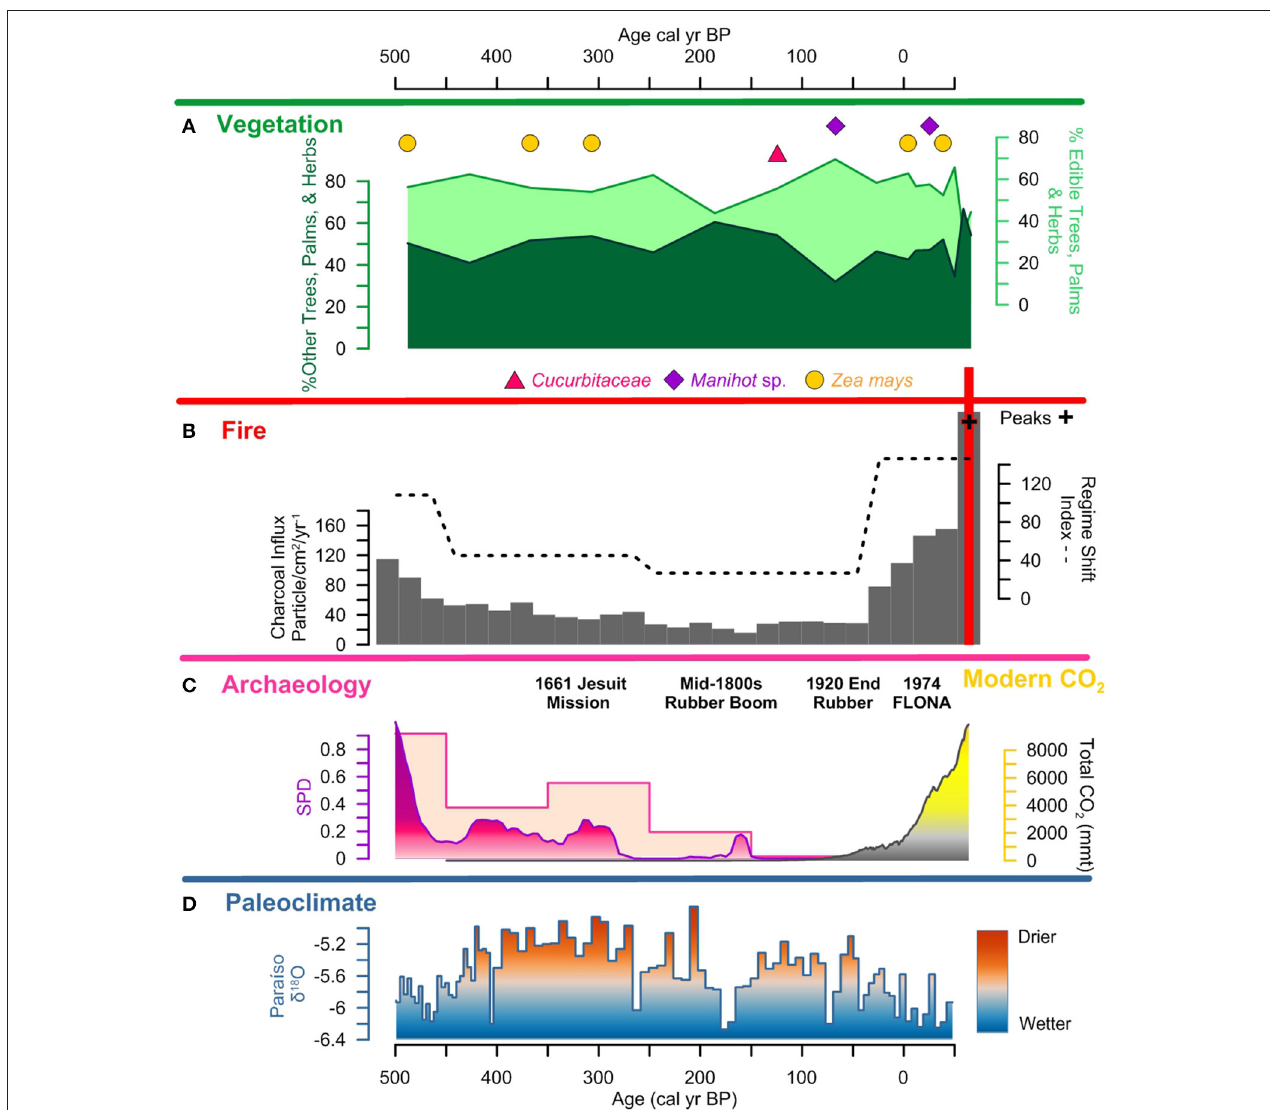
FIGURE 8 | Lago Caranã summary figure 500 cal yr BP to present: (A) vegetation: pollen summary data of edible and other trees, palms, and herbs, and crop pollen including maize ( Z. mays ), sweet potato ( Ipomea sp.), manioc ( Manihot sp.), and squash ( Cucurbita ), (B) fire: charcoal influx with black line indicating background, RSI, fire frequency, peaks, and peak magnitude from CHAR Analysis, and regional charcoal curve from sites compiled from the GCD, (C) archeology: summary data calculated from the sum of calibrated probability distributions (SPDs) and site frequency data (Maezumi et al., 2018), modern CO 2 concentrations in yellow from (Marland et al., 2008) (D) paleoclimate: data from Paraíso Cave (Wang et al.,